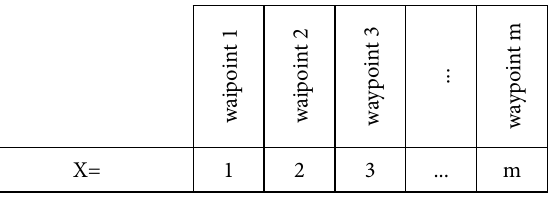
Figure 1. Bit mark initialized of variable X in the path string.